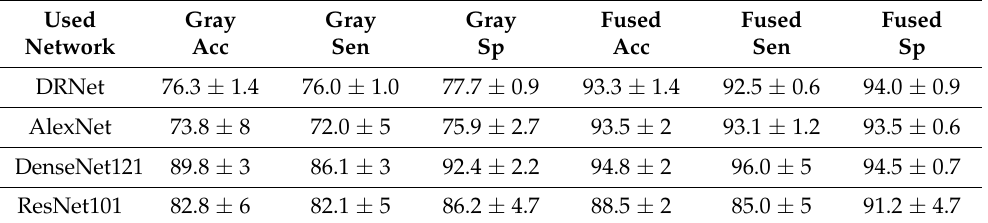
Table 1. Ten-fold accuracy (Acc), sensitivity (Sen), and specificity (Sp) comparisons for fused images and the gray level images trained over different models (all values are percentiles).